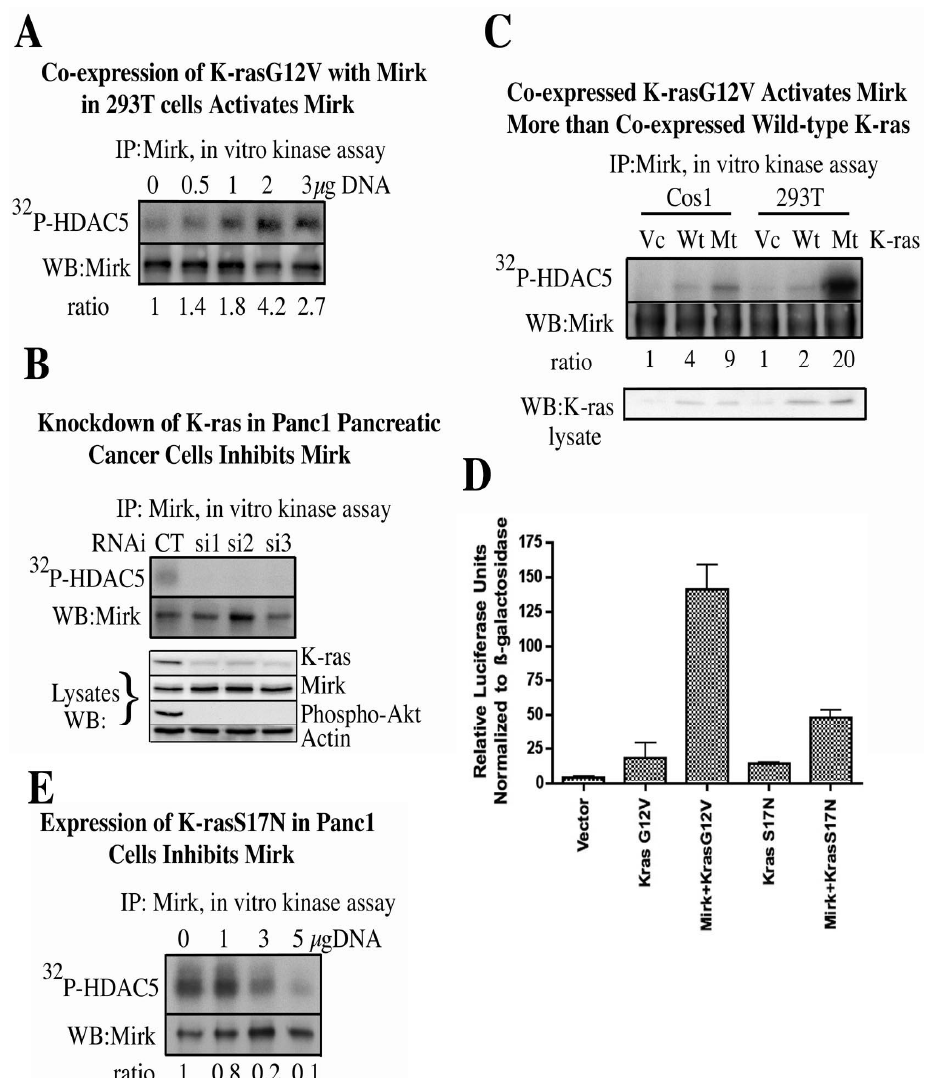
Figure 1. Expression of oncogenic K-ras activates Mirk while depletion of K-ras inhibits Mirk activity. In all studies, as noted, Mirk was immunoprecipitated from the cells using a polyclonal antibody to the unique C-terminus of Mirk. Subsequently, its in vitro kinase activity was measured on a specific Mirk substrate, a 1–283 amino acid N-terminal fragment of histone deacetylase 5 (HDAC5) which contains only one Mirk phosphorylation site at serine 279. ( A ) . 293T cells were co-transfected with expression plasmids for His- Mirk and increasing concentrations of K-rasG12V. ( B ) . K-ras mRNA depleted by three different RNAi duplexes. ( C ) . 293T cells and Cos-1 cells were co-transfected with expression plasmids for His-Mirk and either K-rasG12V, wild-type K-ras or vector control. ( D ) . The ß-fibrinogen reporter construct (ß-28) -Luc was co-transfected in Cos1 cells with 3 expression plasmids for HNF1, oncogenic K-rasG12V or dominant negative K-rasS17N, and Mirk, as noted. E. Increasing amounts of expression plasmid for dominant negative K-rasS17N expressed in Panc1 cells. (Reprinted with permission from